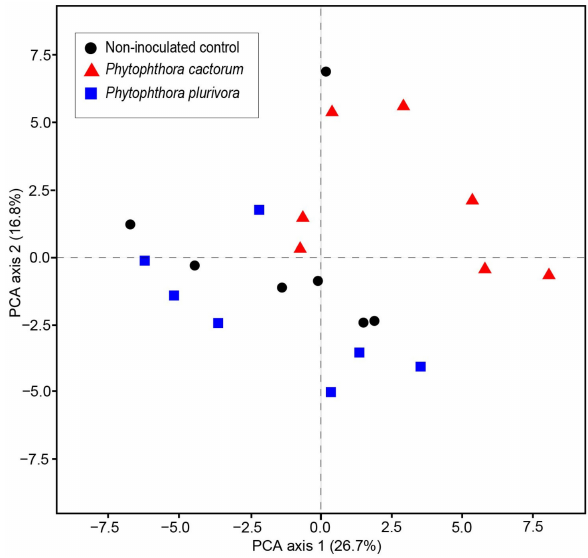
Figure 4. Positions of the examined plants on the first and second axes of the principal component analysis (PCA) based on the measurements of volatile organic compounds at days 9 and 98 p.-i. Control plants, plants inoculated with Phytophthora cactorum and plants inoculated with Phytophthora plurivora are as indicated in the